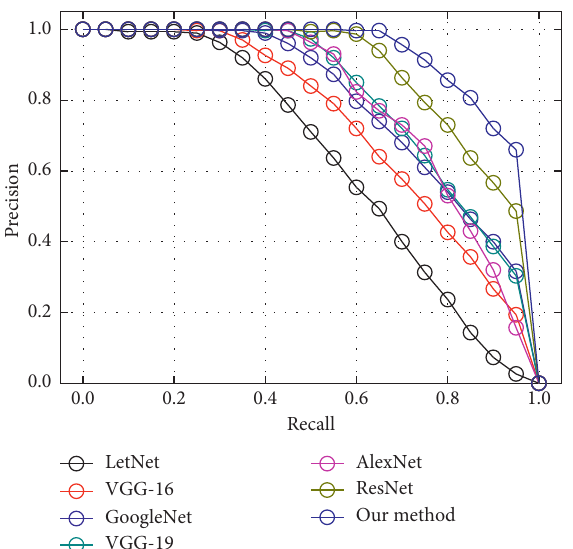
Figure 17: Comparison of P-R curves of face recognition performance of different